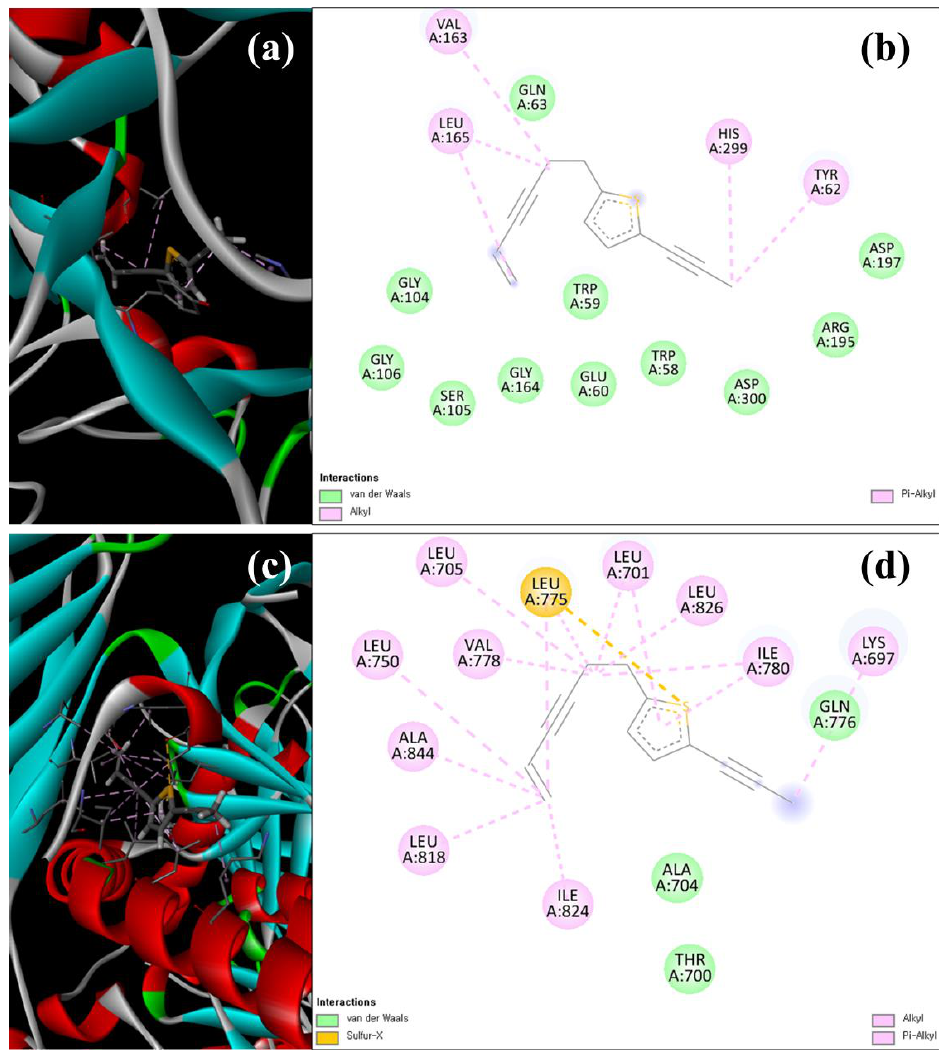
Figure 6. The structural overlay and 3D ( a , c ), and 2D ( b , d ) docking simulation of thiophene A with the crystal structure of α -amylase ( a , b ) and α -glucosidase ( c , d ) during in silico molecular interaction analysis. The 3D simulations represent target proteins (thick tubes), ligands (thin tubes), and interaction forces/bonds (dotted tubes). Table 7. Free binding energies of the tentatively identified compounds from the EAE-PR within the active pockets of α -amylase (PDB: 1OSE), α -glucosidase (PDB: 5NN8), NADPH oxidase (PDB: 2CDU), and D-alanine D-alanine ligase (PDB: 2PVP) during the in silico molecular docking analysis. ND, not determined.